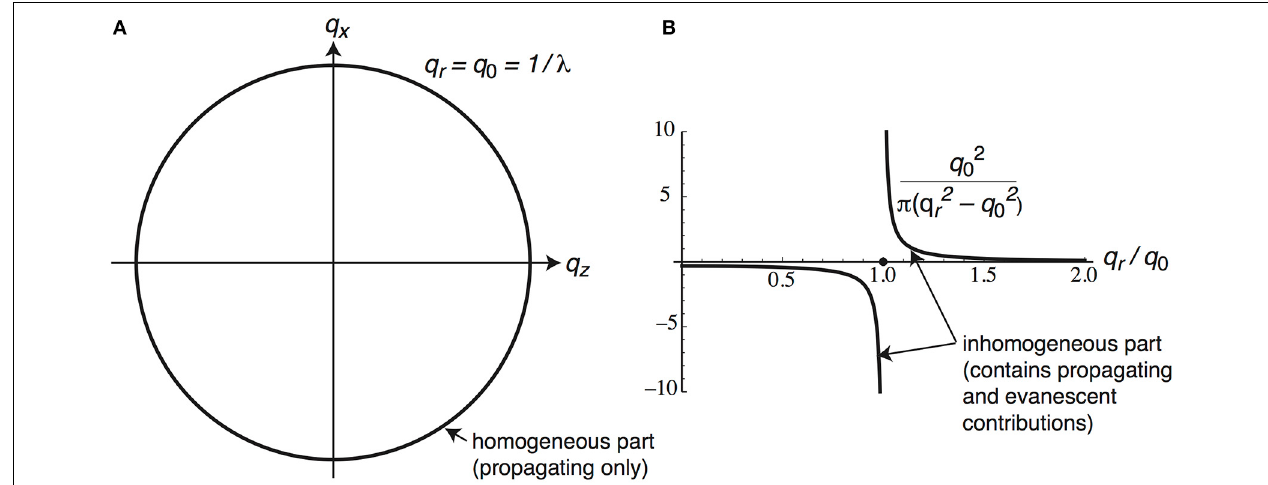
part of the Green function transform (Equation 20) is positive outside of the sphere radius q 0 , zero on the sphere, and negative inside the